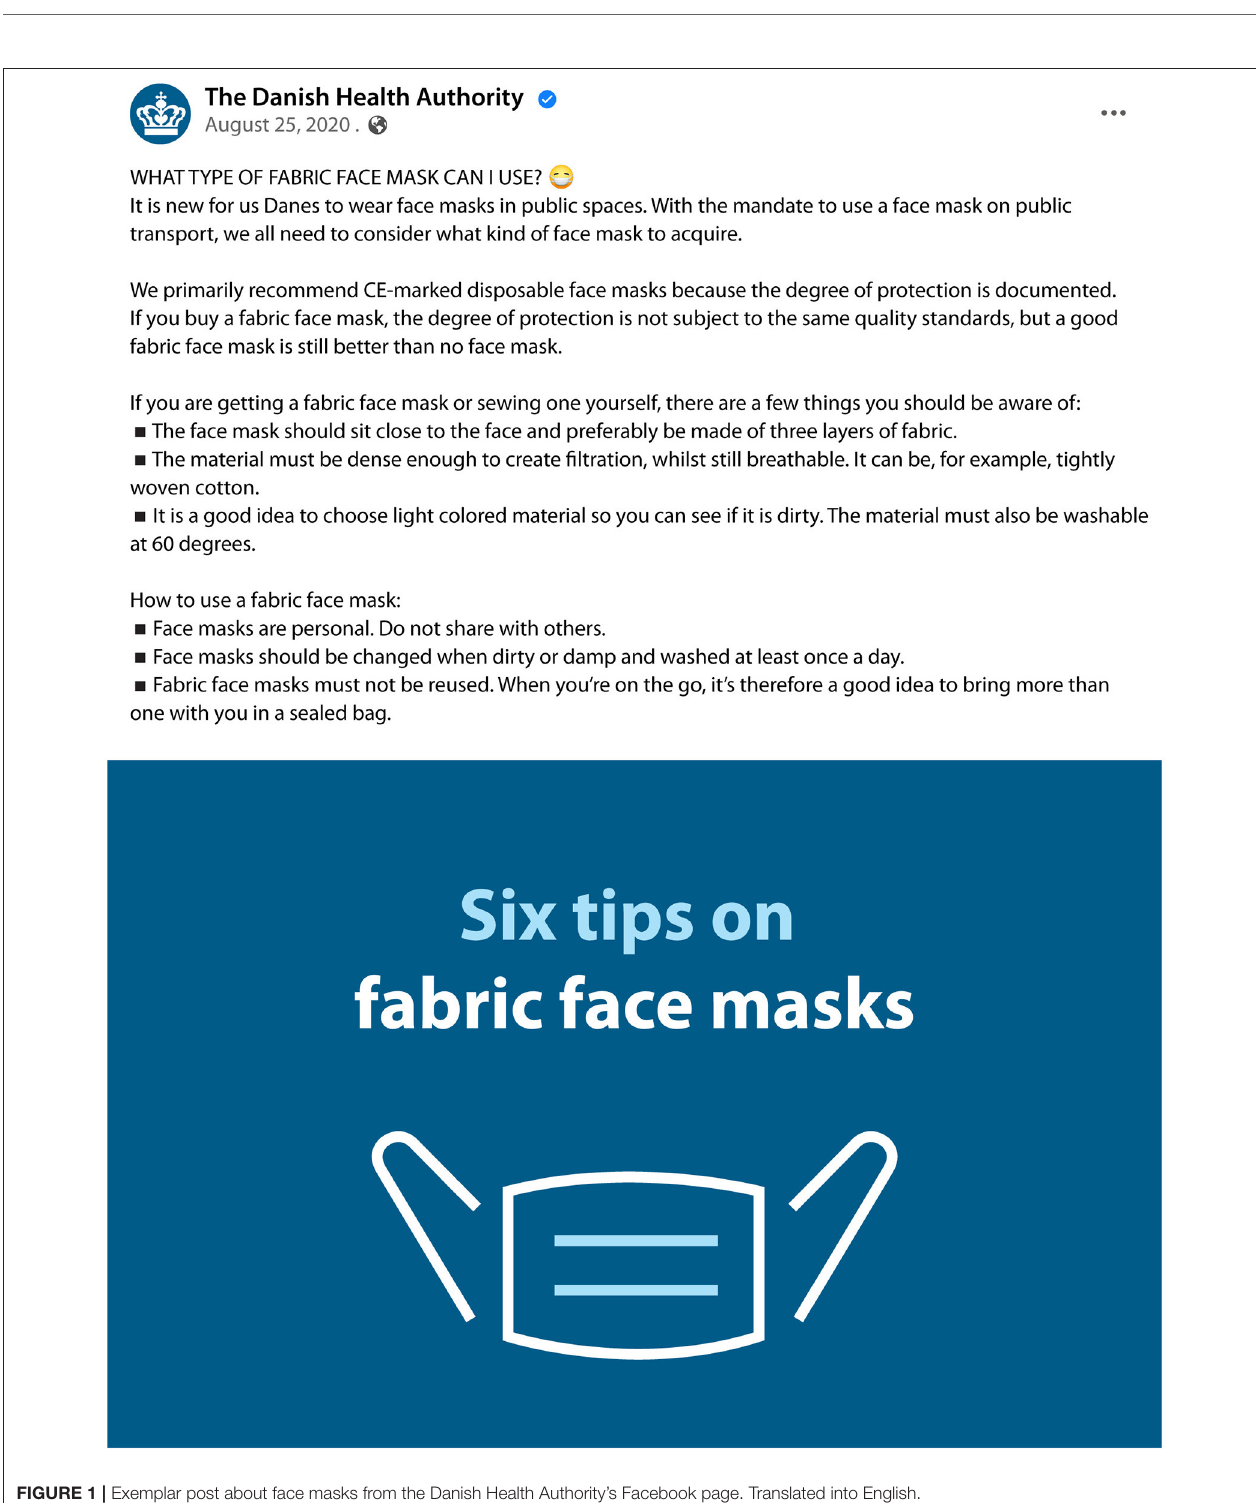
FIGURE 1 | Exemplar post about face masks from the Danish Health Authority’s Facebook page. Translated into